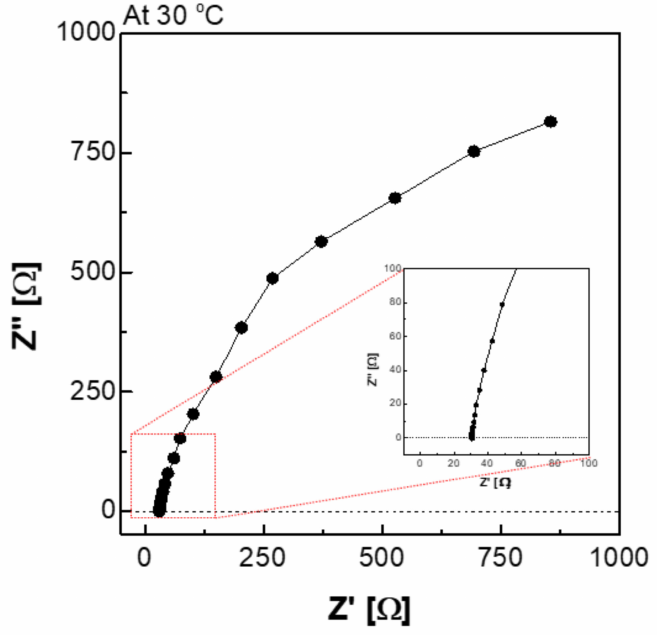
Figure 6. Nyquist plot via the H-type cell in 30 wt.% KOH solution at 30 ◦ C condition. Figure 7 depicts a Nyquist plot of the impedance measured using a zero gap